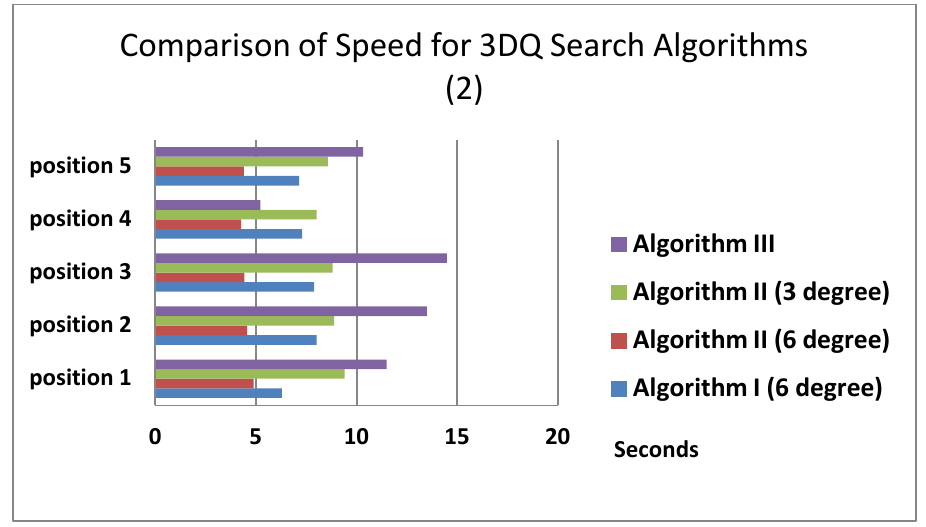
Figure 12. Comparisons of query speed for different search algorithms at five positions on large 3D solid dataset of Dublin City.